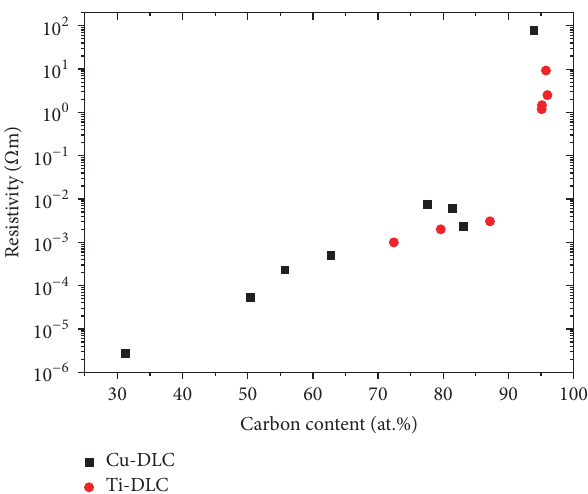
Figure 8: Friction coefficients as a function of number of rotations of Ti-DLC